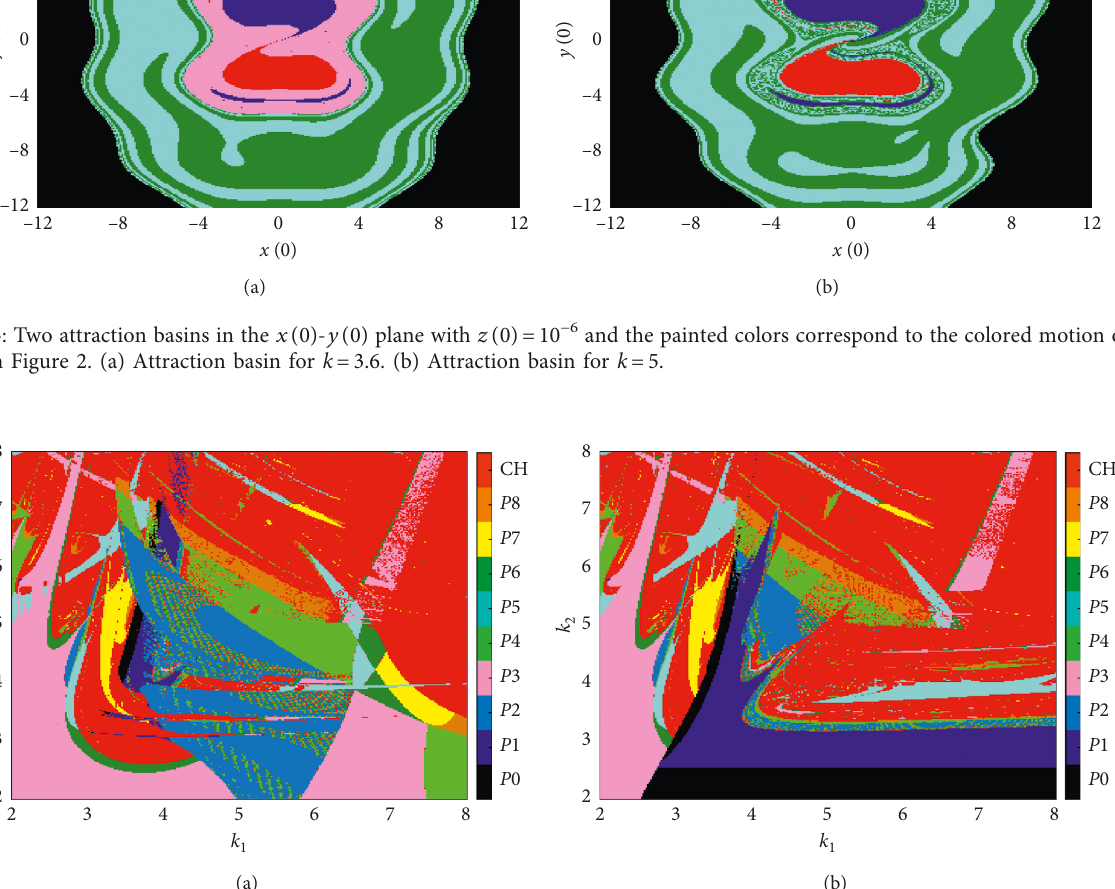
Figure 4: Two-dimensional bifurcation diagrams in the k 1 - k 2 parameter plane through calculation of the periodicities of the state variable x under two sets of initial values. (a) Initial values (10 − 6 , 0, 0). (b) Initial values (10 − 6 , 3, 0).